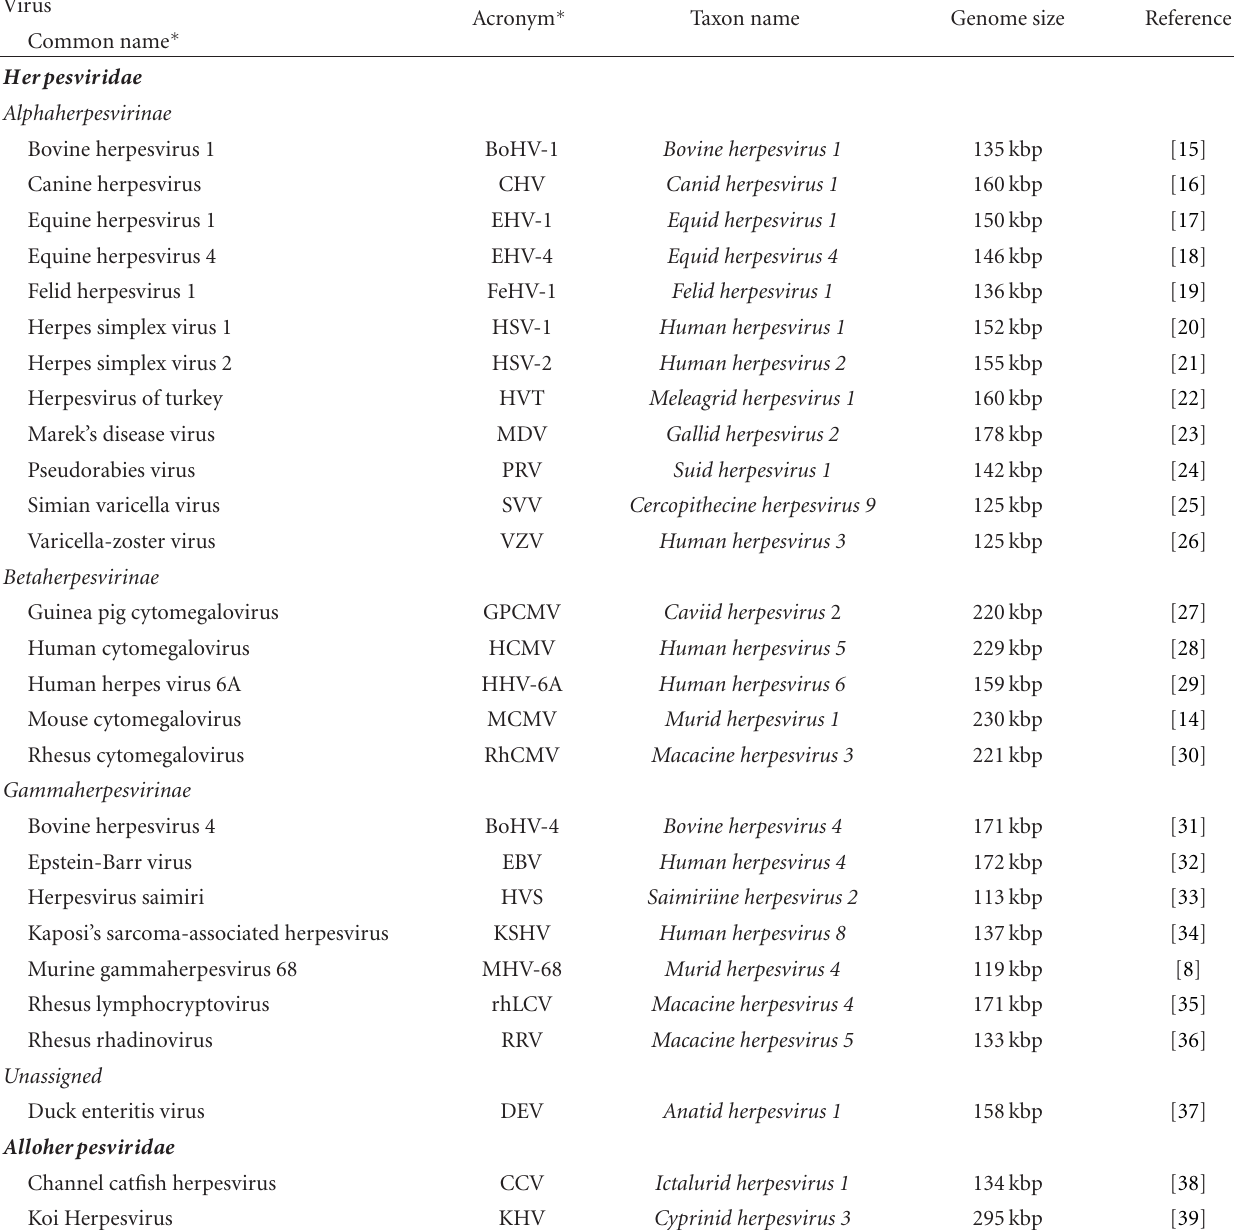
Table 1: Overview of published BAC systems for species of the order Herpesvirales. Common species names, corresponding acronyms, taxon names, genome sizes, and references for the first BAC construct of every species are given. ∗ Common names and acronyms are as they were used in the listed